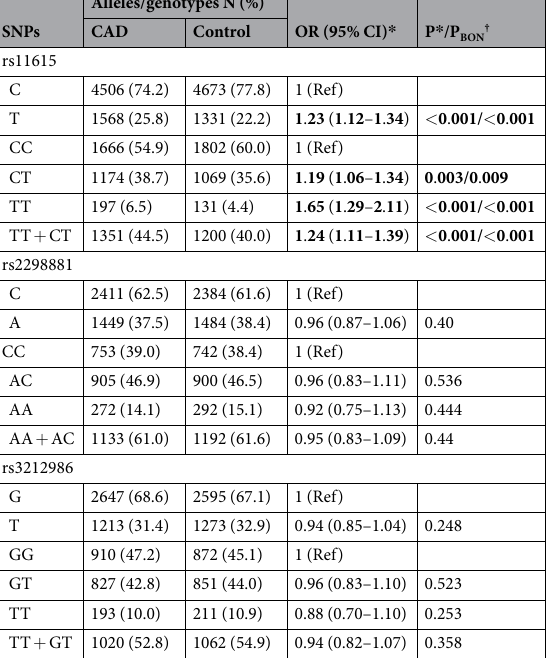
Table 2. Association of ERCC1 SNPs with CAD risk in 3037 CAD patients and 3002 controls. CAD, coronary artery disease; N: number; OR (95% CI): odds ratio (95% confidence interval); Ref: reference. * Adjusted OR (95% CI) and P values were obtained from logistic regression analyses after adjusting for age, sex, BMI, smoking status, alcohol drinking and histories of T2DM, hyperlipidemia and hypertension. † Multiple testing by the Bonferroni correction, P-value multiplied 3 (3 SNPs) to get a P BON value. Bold values are statistically significant with P <